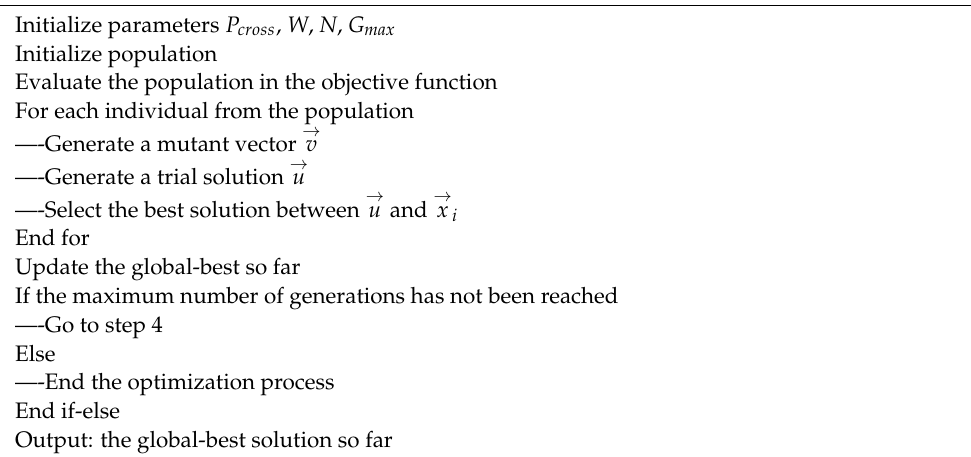
Algorithm 1. Optimization strategy using